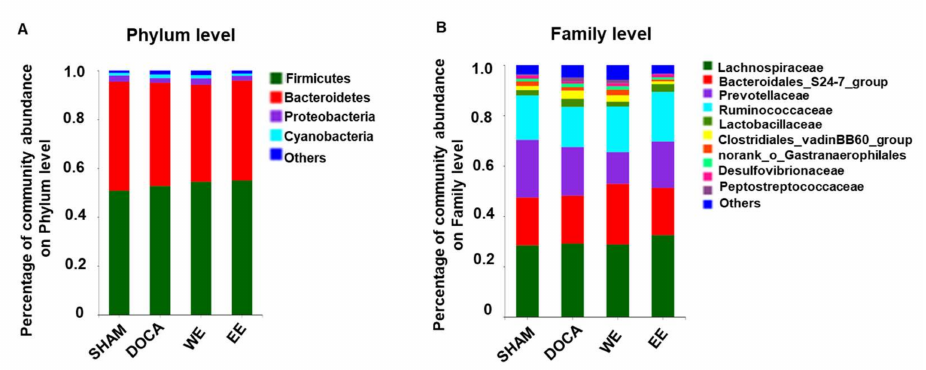
Figure A3. Effect of water extract and ethanol extract of L. rhamnosus AC1-fermented soymilk on the microbial composition in the gut flora of DOCA-salt hypertensive rats at week 0. Percentage of community abundance on the phylum ( A ) and family levels ( B ).